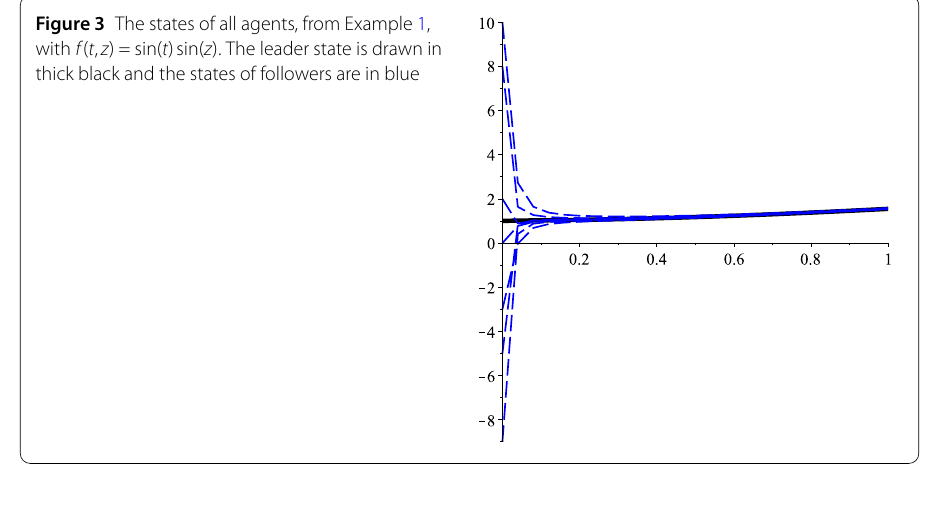
Figure 4 The states of all agents, from Example 1, with β ( t ) = 90 + sin( t ). The leader state is drawn in thick black and the states of followers are in